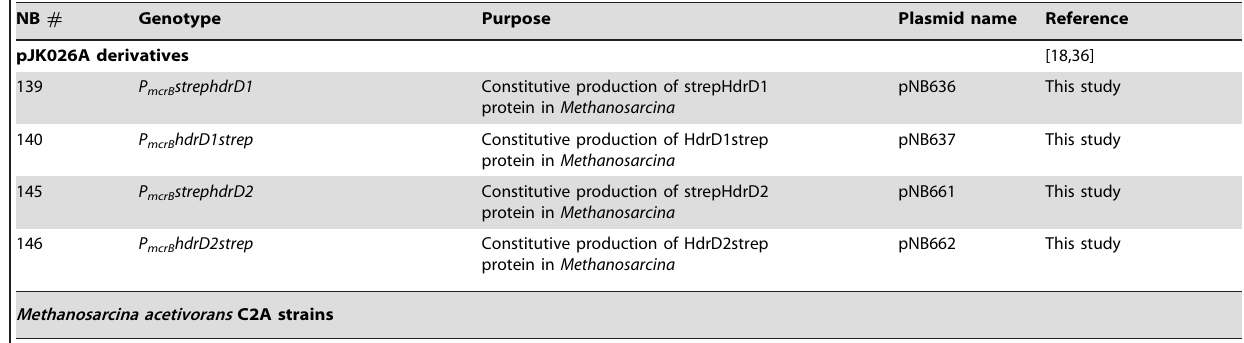
Plasmids and E.coli strains